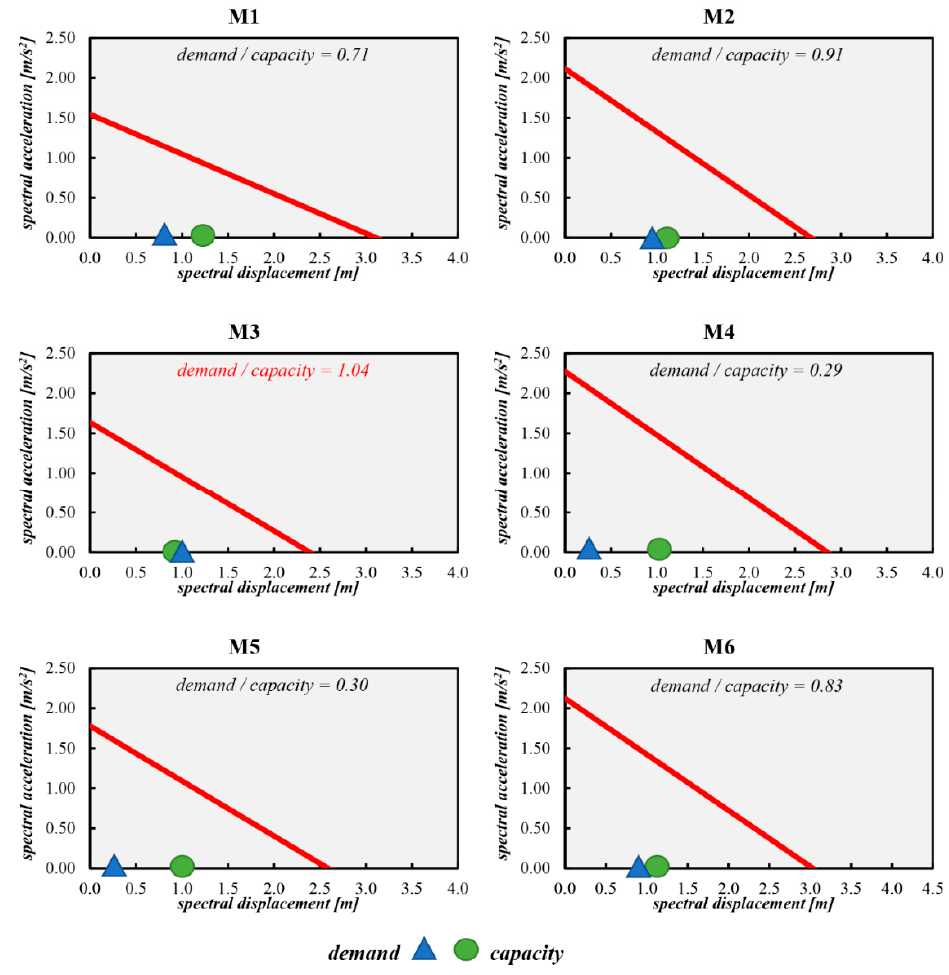
Figure 13. Non-linear kinematic analysis: capacity curves.